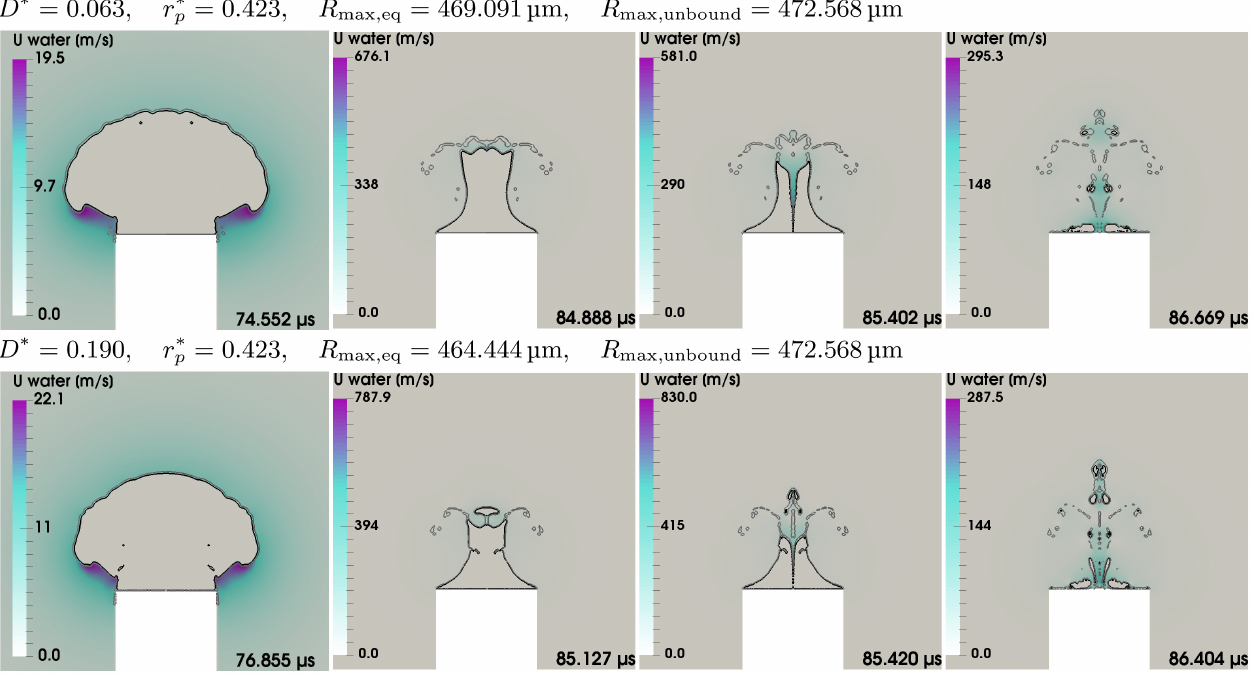
Figure 17. Mushroom bubbles with the magnitude of the flow velocity of the liquid. Bubbles at the same r ∗ p = 0.423 for two different normalized distances D ∗ with the same R max,unbound . The individual color scales give the maximum velocity in the respective frame. Note the small bubble in the second row, second frame, on top of the bubble stem and the stack of small (torus) bubbles that are shot upwards away from the pillar by the upwards flow after annular-flow impact (last column). They can be identified with the projectile in the experiment. When comparing with the experiment, note that the numeric pictures are presented as a cut through the bubble and should be complemented by rotation of the cut for a full bubble view. Cylinder radius is